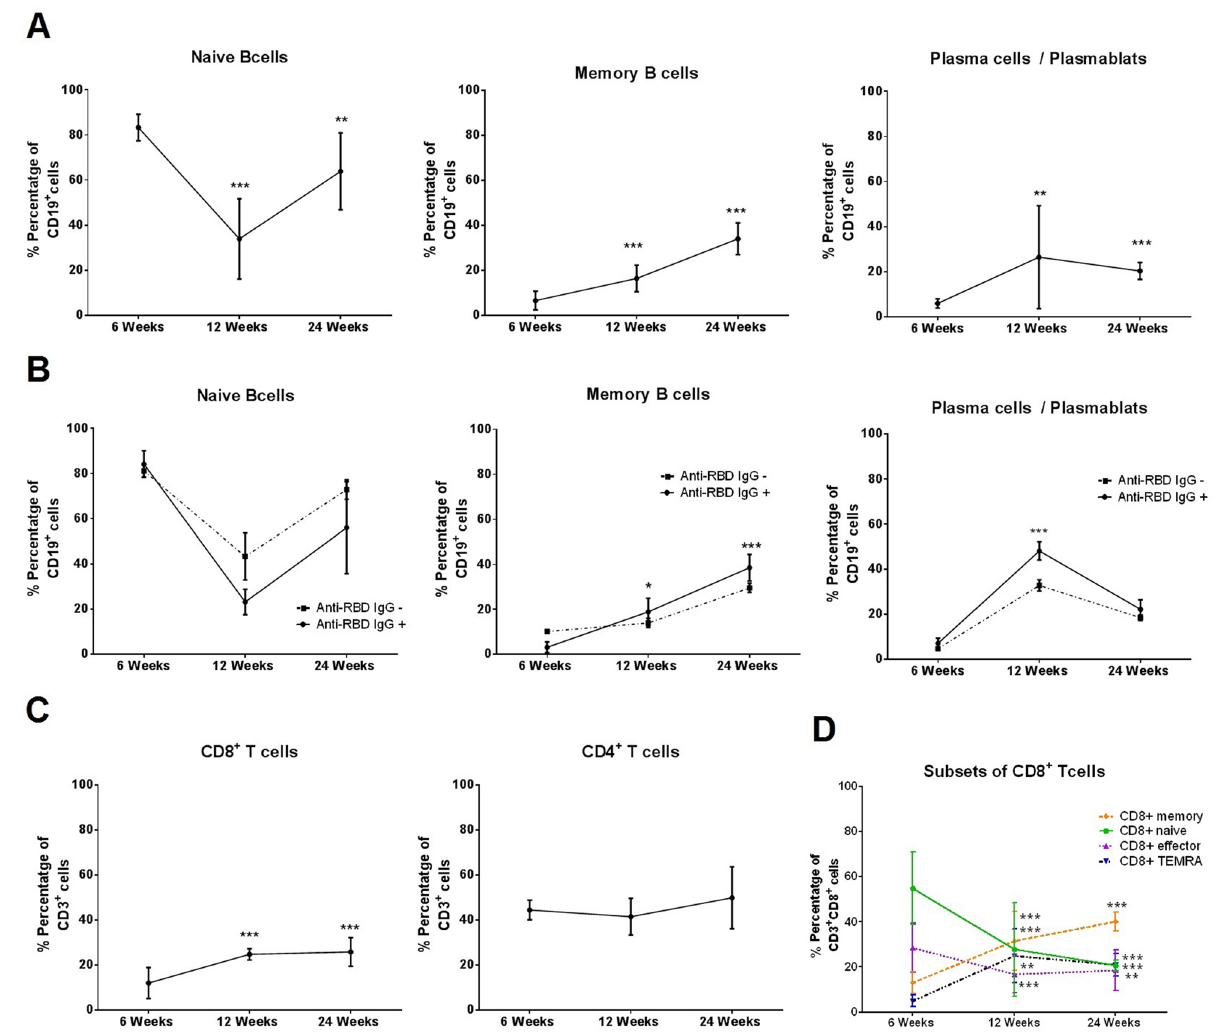
Figure 4. Longitudinal cellular profile revealed an enrichment of memory B and CD8 + T cell in exposed SARS-CoV-2 lupus patients. ( A ) Longitudinal study of the percentage of CD19 + IgD − CD27 − (naïve B cells), CD19 + IgD + CD27 + (memory B cells) or CD19 + CD27 + CD38 + (plasma cells / plasmablasts) at 6, 12 and 24 weeks after onset of symptoms in SARS-CoV-2 exposed lupus patients (N = 12). Significant differences were calculated in comparison with the 6-week timepoint using paired t-test. * p < 0.05, ** p < 0.005, *** p < 0.0001. ( B ) Patients who produced SARS-CoV-2 antibodies against RBD protein (anti-RBD IgG + ) have significantly increased levels of memory B cells at Week 12 and 24, and antibody-producing cells (plasma cells / plasmablasts) at Week 12 compared with anti-RBD IgG − patients. No differences were found in naïve B cells. Fold change significant differences over time were calculated between groups by linear mixed models. * P < 0.05, *** p < 0.001. ( C ) By flow cytometry, CD3 + CD8 + T cell percentages were significantly increased after 6 weeks. No differences were found in CD3 + CD4 + T cells. p -values were obtained using paired t-test . * p < 0.05, ** p < 0.005, *** p < 0.0001. ( D ) Longitudinal dynamics of CD8 + T cell subtypes in convalescent SARS-CoV-2 lupus patients at 6-, 12- and 24-weeks post symptom onset. The vertical axis shows the percentage of CD3 + CD8 + cells, and the horizontal axis shows time. Error bars represent the mean ± SEM from 12 lupus patients. Significant differences were calculated in comparison with the 6-week timepoint using paired t-test. ** p < 0.005, *** p <